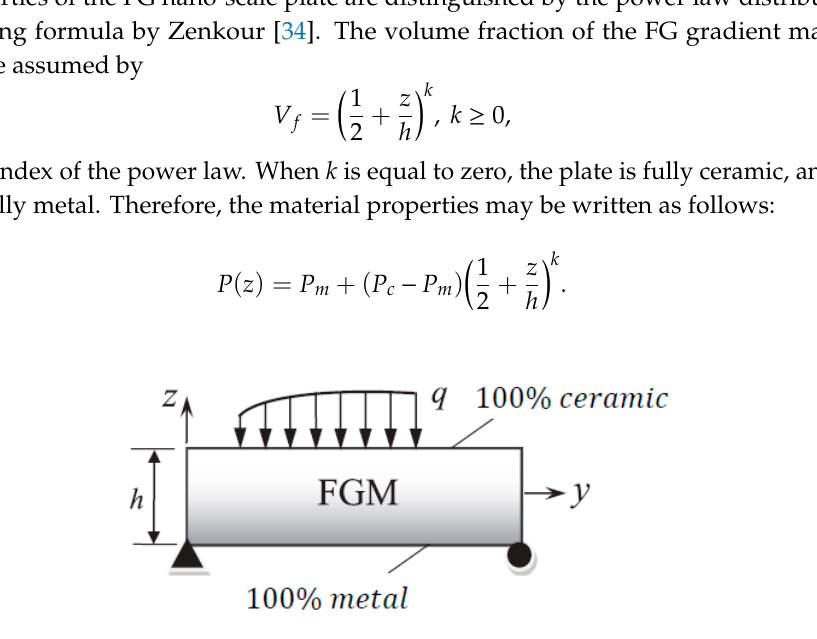
Figure 1. Geometry of the nanoplate made of functionally graded materials (FGM).